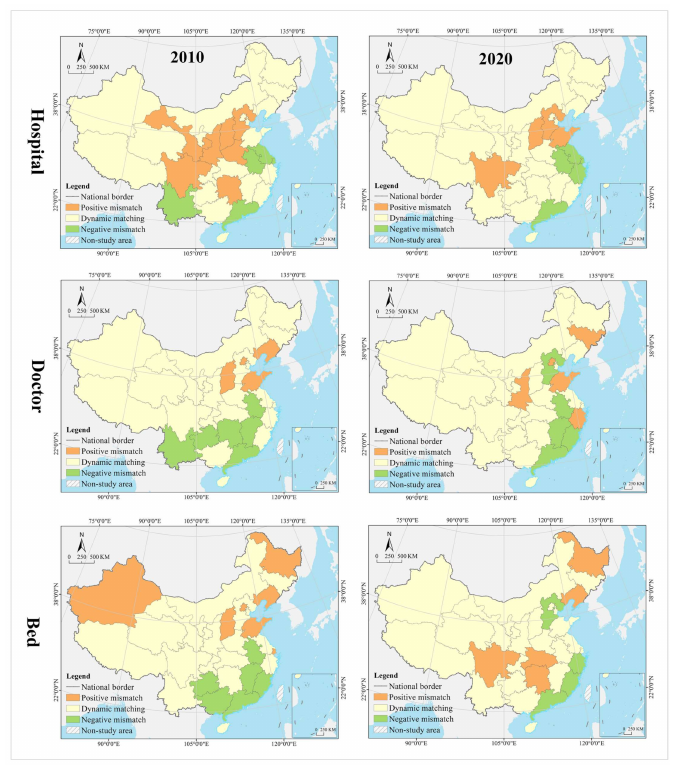
Figure 7. Spatial clustering analysis of mismatch type for